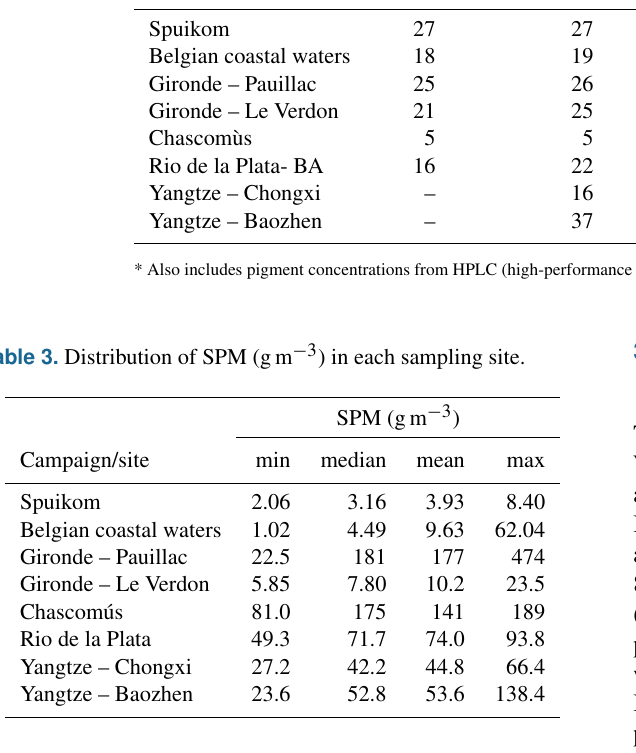
Table 4. Distribution of Chl- a concentration (mgm − 3 ) in each sampling